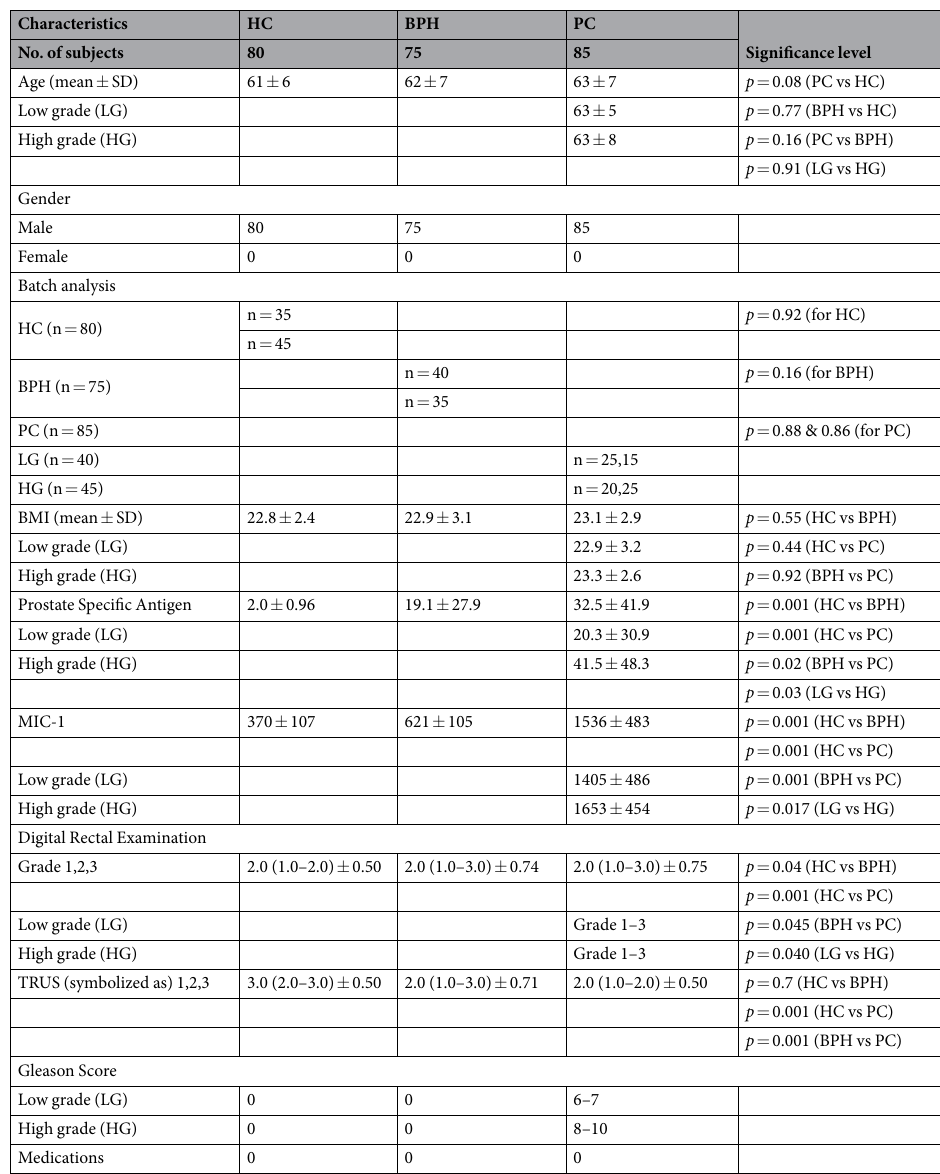
Table 1. Summary of clinical information’s of healthy control (HC), benign prostate hyperplasia (BPH) and prostate cancer (PC) patients. hypoechoic lesion denoted as 1, hyperechoic lesion denoted as 2, isoechoic lesion denoted as 3 PSA levels were appraised by one-way ANOVA followed by a post hoc Student-Newman-Keuls multiple comparisons test, categorical variables (DRE and TRUS) were assessed by nonparametric ANOVA followed by Kruskal-Wallis multiple comparisons test and paired t-test was applied between LG vs. HG cases as well as batch analysis. DRE and TRUS are presented as median (range) ±